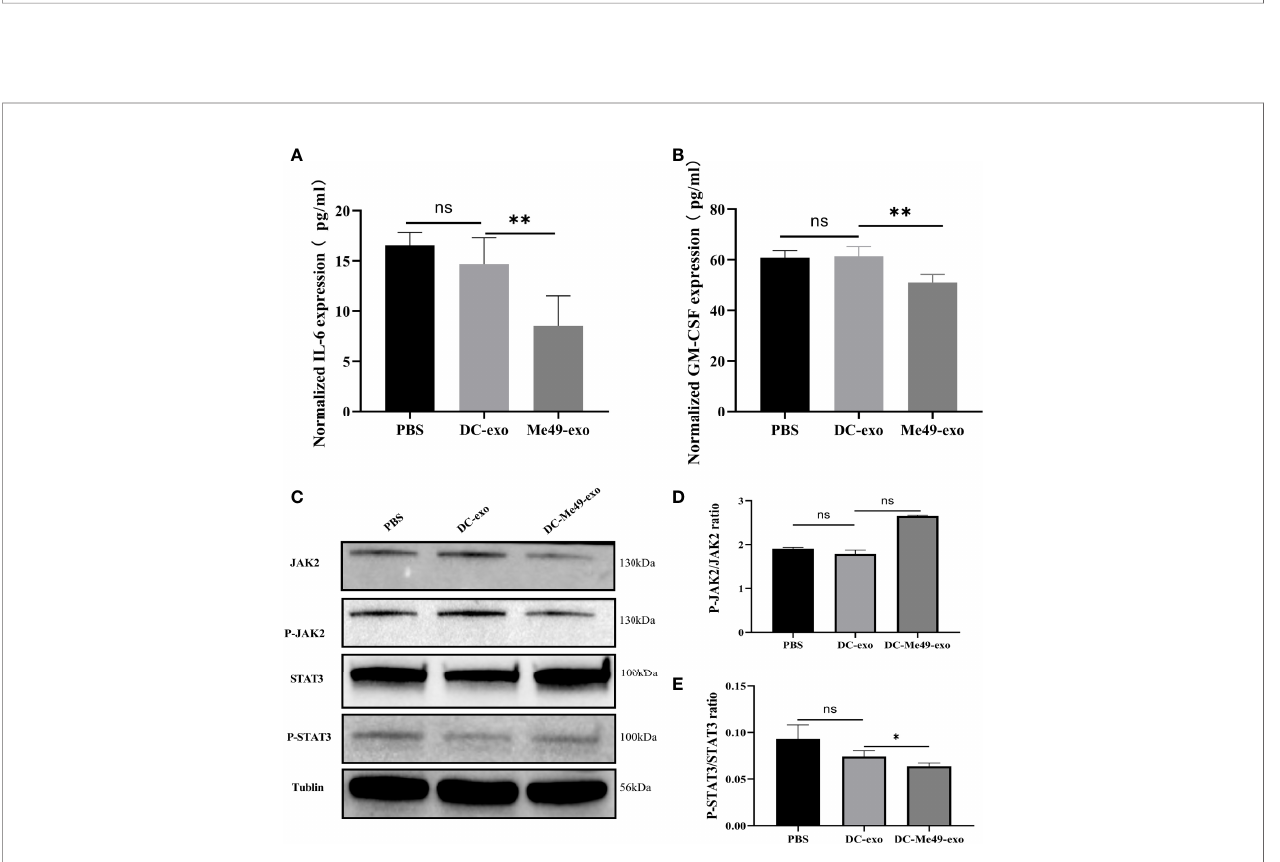
FIGURE 6 | DC-Me49-exo regulated MDSCs by affecting the STAT3 pathway. Concentrations of IL-6 (A) and GM-CSF (B) in sera of tumor-bearing mice treated with DC-exo, DC-Me49-exo and PBS. (C) Protein expression levels at the JAK2/STAT3 pathway. The grayscale analysis of the ratio of P-STAT3/STAT3 (D) and P-JAK2/JAK2 (E) . ns, ( p ≥ 0.05), * p < 0.05, ** p <